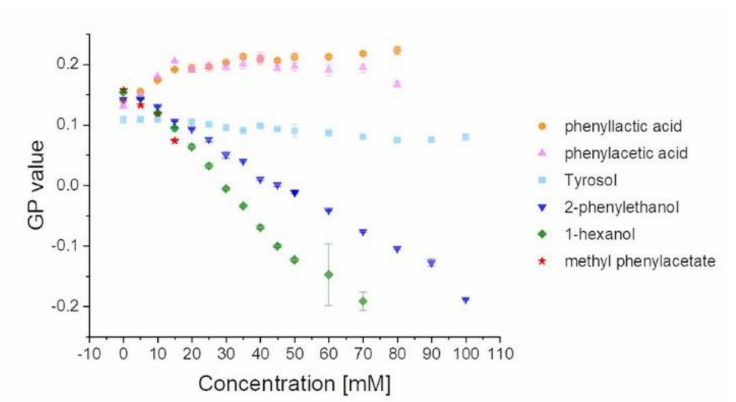
Figure 3. 2-PEtOH and derivatives affect the structure of the model membranes. GP values deter- mined at increasing substance concentrations are shown. The values indicate a fluidizing effect for the more hydrophobic substances 1-hexanol, 2-PEtOH, and methyl phenylacetate. Tyrosol seems to be largely ineffective, while phenyllactic acid and phenylacetic acid seem to have a slight ordering